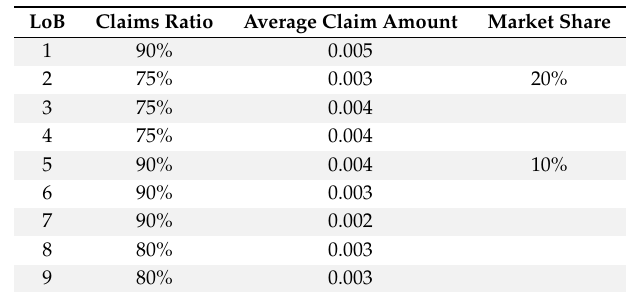
Table 5. Claims ratio, average claim amount (in millions of CHF) and market